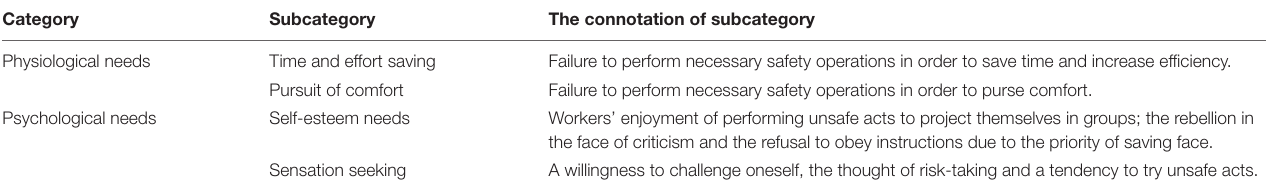
TABLE 3 | Categories developed through axial coding and the connotation of subcategory (excerpted